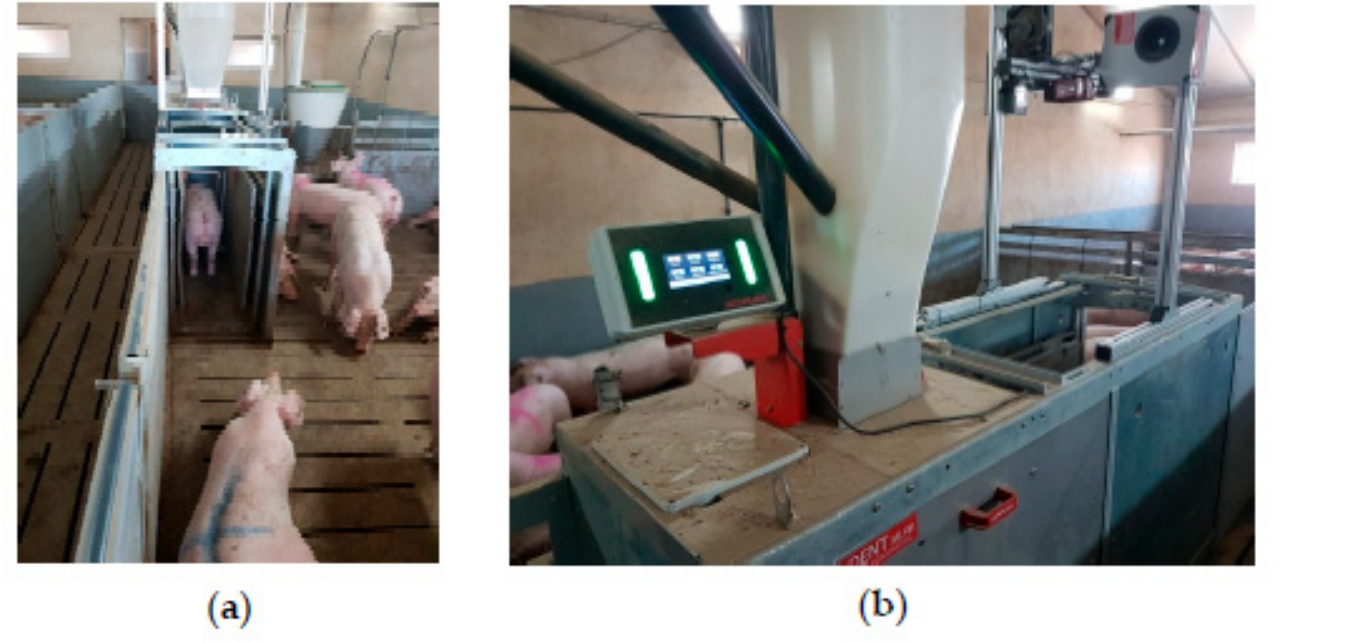
Figure 3. Compident MLP (Schauer Agrotonic GmbH, Austria) used in the study of Garrido-Izard et al. [49]. ( a ) Weighing scale. ( b ) Feeding station used during the experiment (Source: [49]).